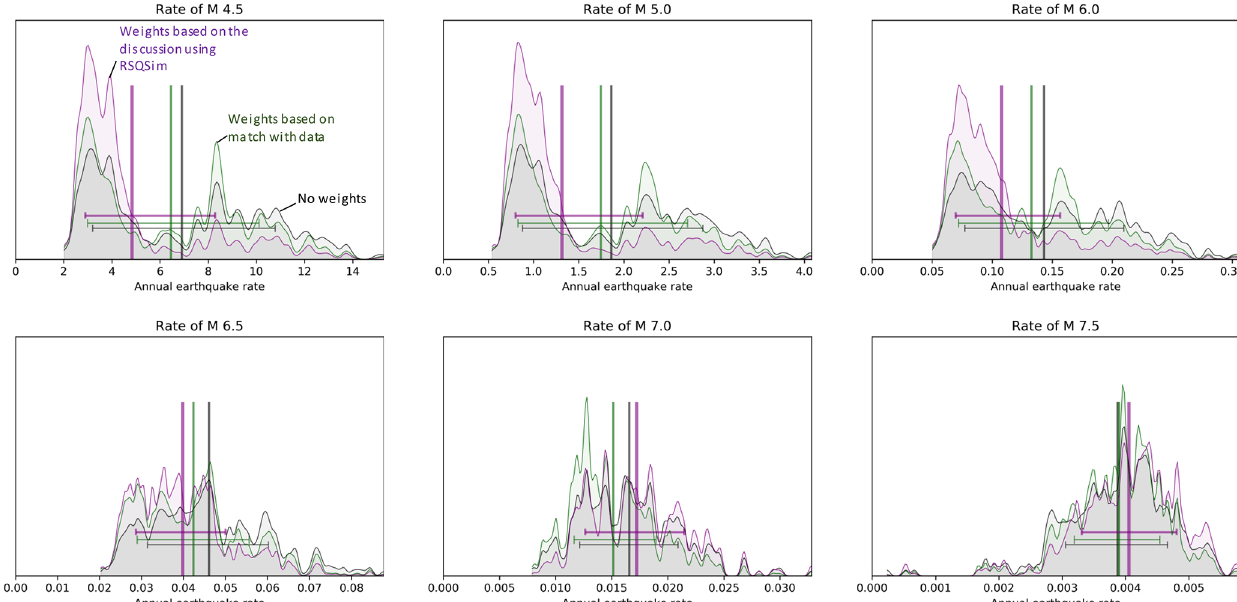
Figure 13. Density function distribution of the cumulative earthquake rates in the logic tree for the central zone for different magnitudes. In black is the density function distribution when only the scoring according to the NMS is applied. In green is the density function distribution weighted according to the fit with the data (catalogue and palaeoseismicity). In purple is the final density function distribution of earthquake rates weighted according to the match with the data and the discussion based on RSQSim. The vertical bar shows the mean annual earthquake rate of each distribution. The horizontal bar extends between the 16th percentile and the 84th percentile of each